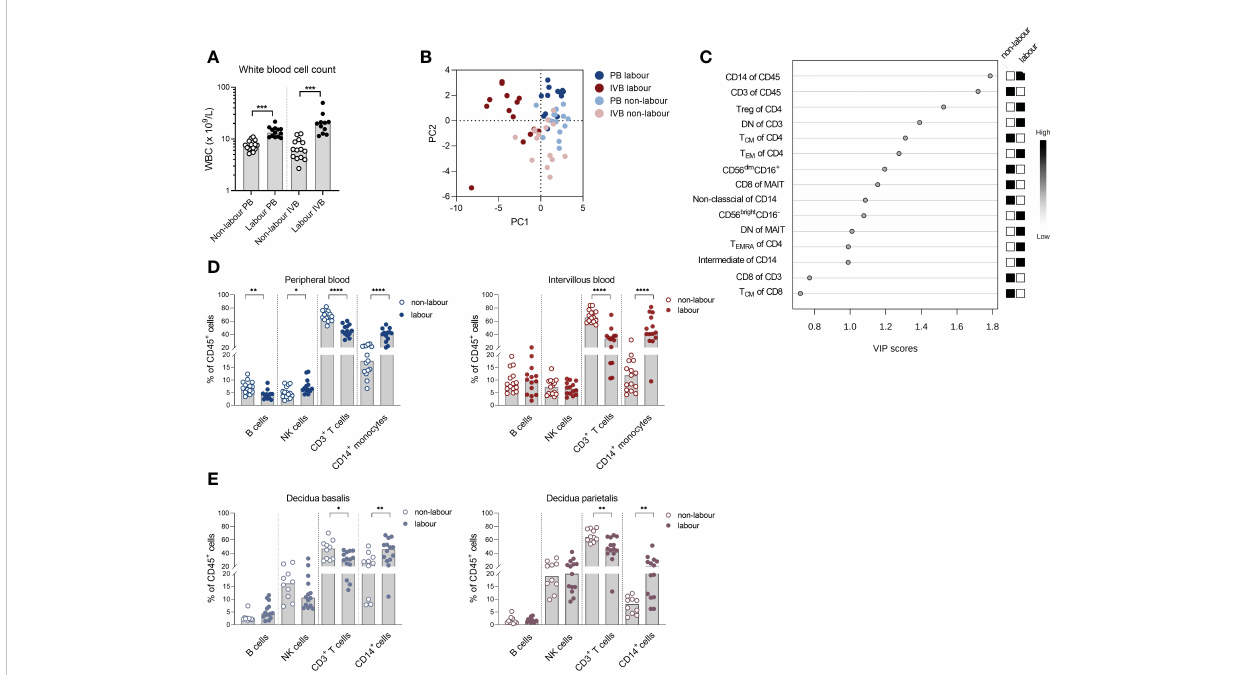
FIGURE 1 Labour promotes a systemic and local monocyte mobilisation. (A) White blood cell count (WBC) in peripheral- (PB) and intervillous blood (IVB) from women delivering with labour (n=14) or without labour (n=15) using a Sysmex automatic cell counter. (B) Principal component analysis (PCA) on mononuclear cells from PB and IVB from women delivering with or without labour based on immune parameters shown Supplementary Table S2. (C) OPLS-DA loading plot displaying the top 15 most important variables (Supplementary Table S2) for the separation between labour and non- labour in IVB samples. (D) Flow cytometric determination of proportions of the major leukocyte populations CD14 + monocytes, CD3 + T-cells, NK cells and B cells in PB and IVB from women delivering with labour or without labour. (E) Flow cytometric determination of the proportion of leukocyte subsets in decidua basalis and decidua parietalis isolated from women delivering with labour (n=14) or without labour (n=10). Data is presented as median and statistical differences were determined with Wilcoxon signed rank test (A) and Mann-Whitney test (D, E) , *p<0.05, **p<0.01, ***p<0.001,